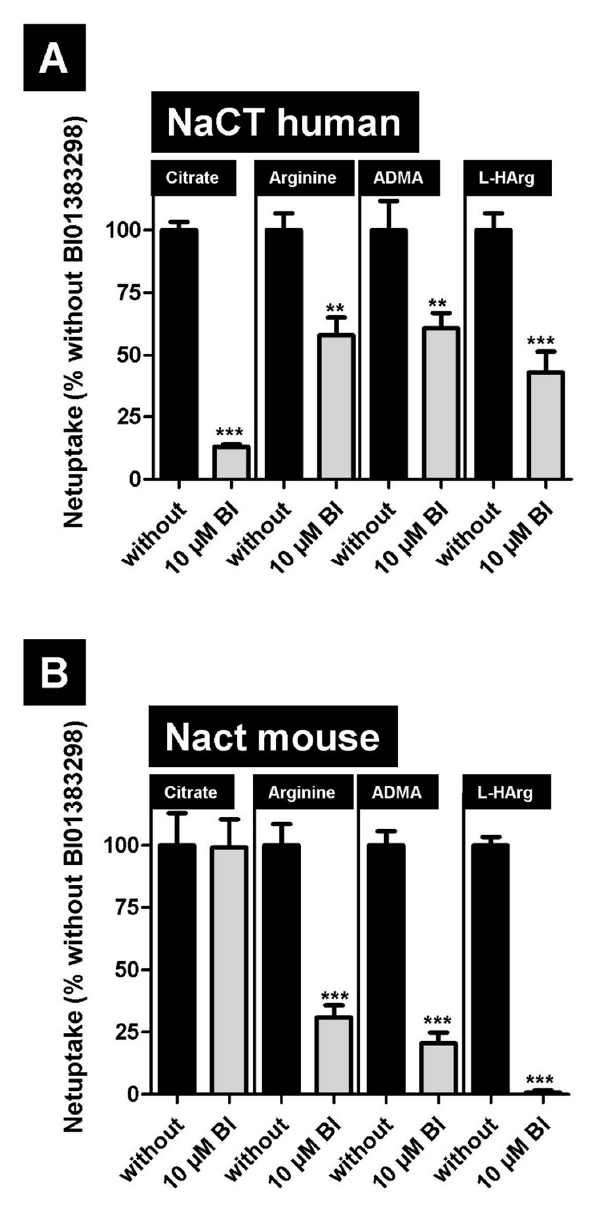
Figure 5. Inhibition of ( A ) human NaCT- and ( B ) mouse Nact-mediated citrate (1 µM), arginine (10 (10 µ M), asymmetric dimethylarginine (ADMA, 10 µ M) and L-homoarginine (L-HArg, 10 µ M) µM), asymmetric dimethylarginine (ADMA, 10 µM) and L-homoarginine (L-HArg, 10 µM) uptake by BI01383298. Cells were preincubated with 10 µM BI01383298 for 30 min before uptake experi- ments. Net uptake without added inhibitor was set to 100% (black bars). ** p < 0.005, *** p < 0.001 vs uptake without BI01383298.